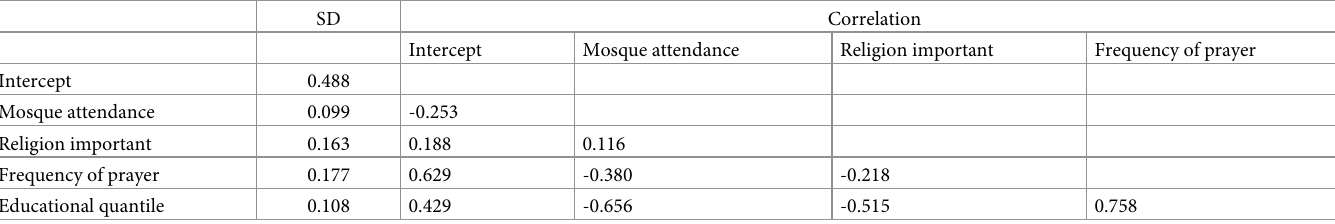
Table 2. Standard deviation and correlation between random intercepts and slopes for religiosity and